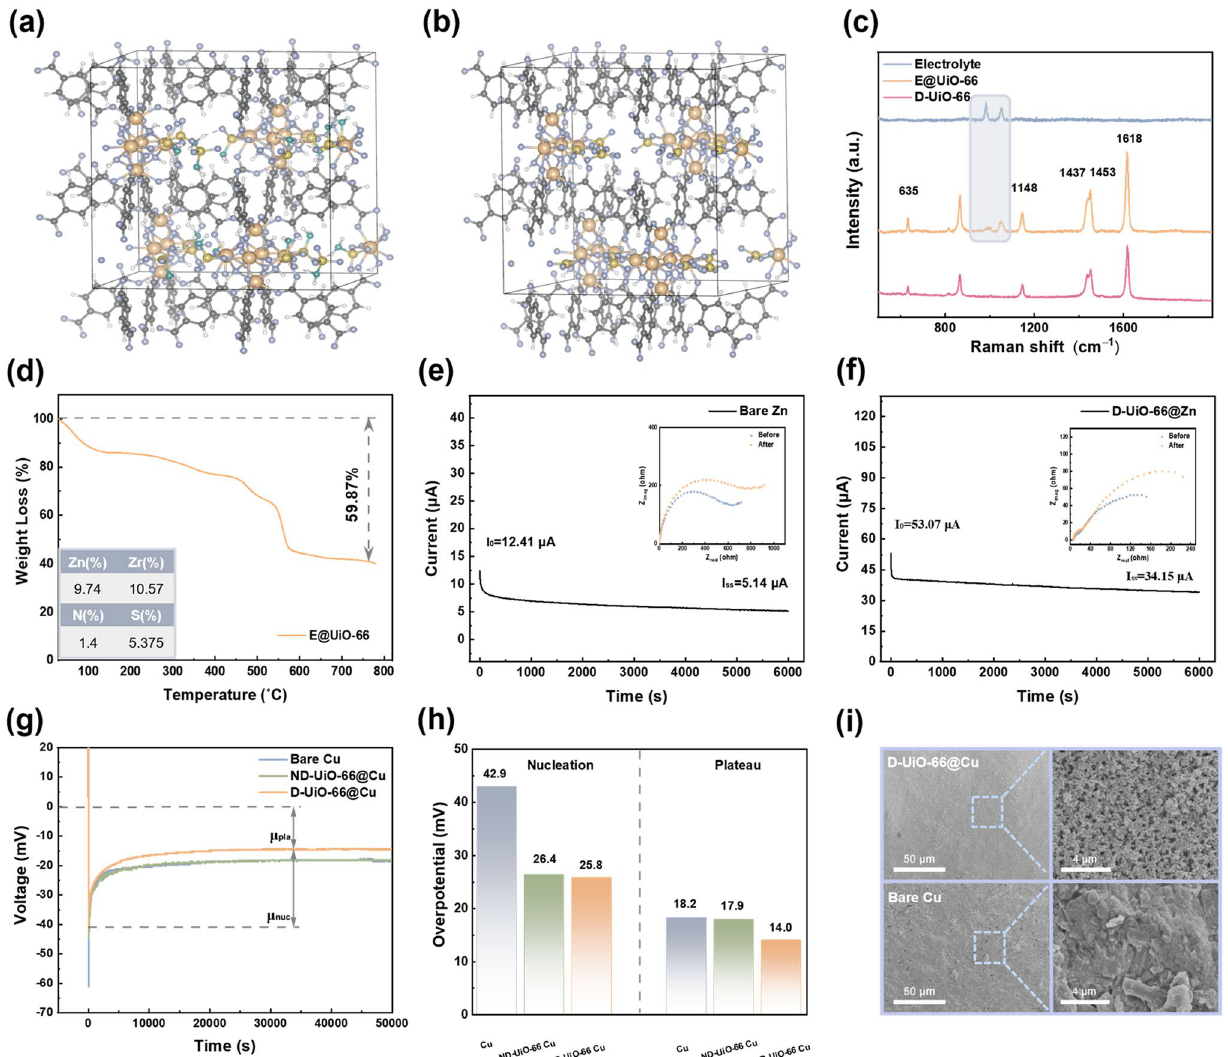
Fig. 2 DFT calculations of a NH 2 SO 3 − and b SO 4 2− adsorbed on the defect sites (white, gray, yellow, purple, orange, and cyan represent hydro- gen, carbon, sulfur, oxygen, zirconium, and nitrogen atoms, respectively). c Raman spectra of E@D-UiO-66 in comparison with liquid elec- trolyte and D-UiO-66 nanoparticles without pretreatment. d TGA curve of E@D-UiO-66 in air. Inset shows the result of ICP-AES. Current– time profile for e Zn||Zn symmetric cell and f D-UiO-66@Zn||D-UiO-66@Zn symmetric cell with potentiostatic polarization ( ∇ V = 10 mV). Insets show AC impedance spectra before and after the following polarization. g Voltage profiles of Zn deposition on various Cu substrates at 0.5 mA cm −2 and the h corresponding overpotential in the different regions. i SEM images of Zn deposition morphology with and without quasi- solid artificial